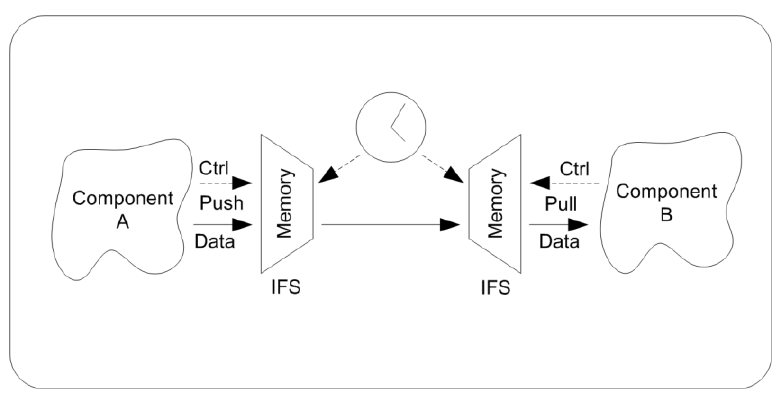
Figure 3. Decoupled flow control.